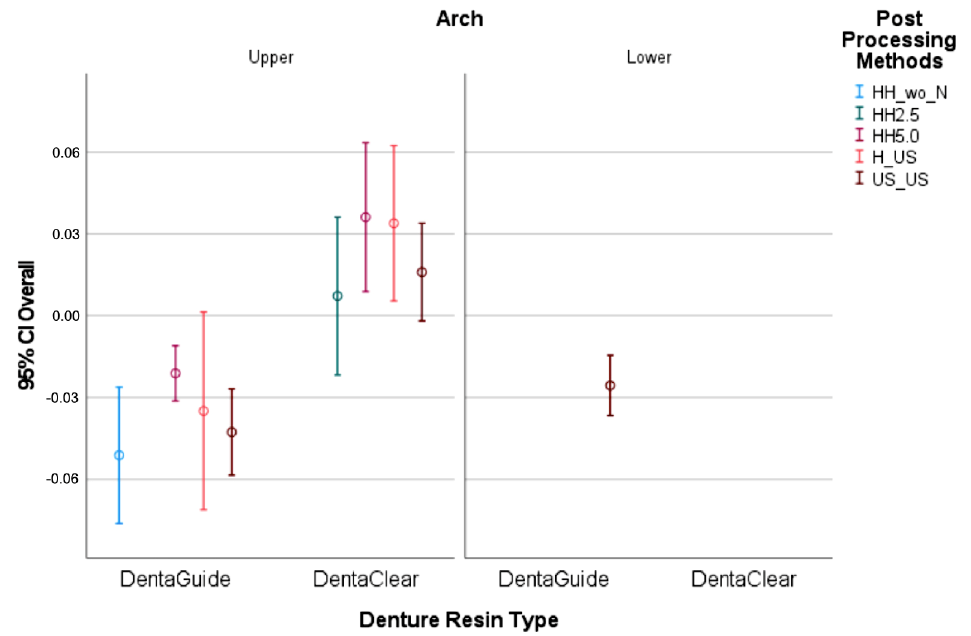
Figure 5. Confidence interval and mean demonstrating trueness (mean) and precision (IQR) in a box plot. Note: handwashing without nitrogen (HH wo N), handwashing for 2.5 min (HH 2.5), handwashing for 5 min (HH 5.0), handwashing and sonication (H_US), sonication (US_US). All measurements are in millimetres.